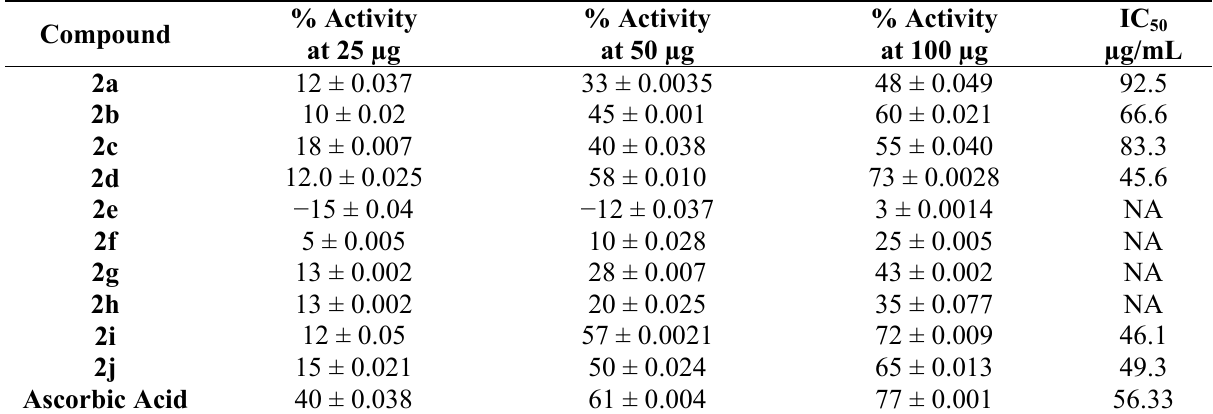
Table 5. NO scavenging activity of synthesized compounds.